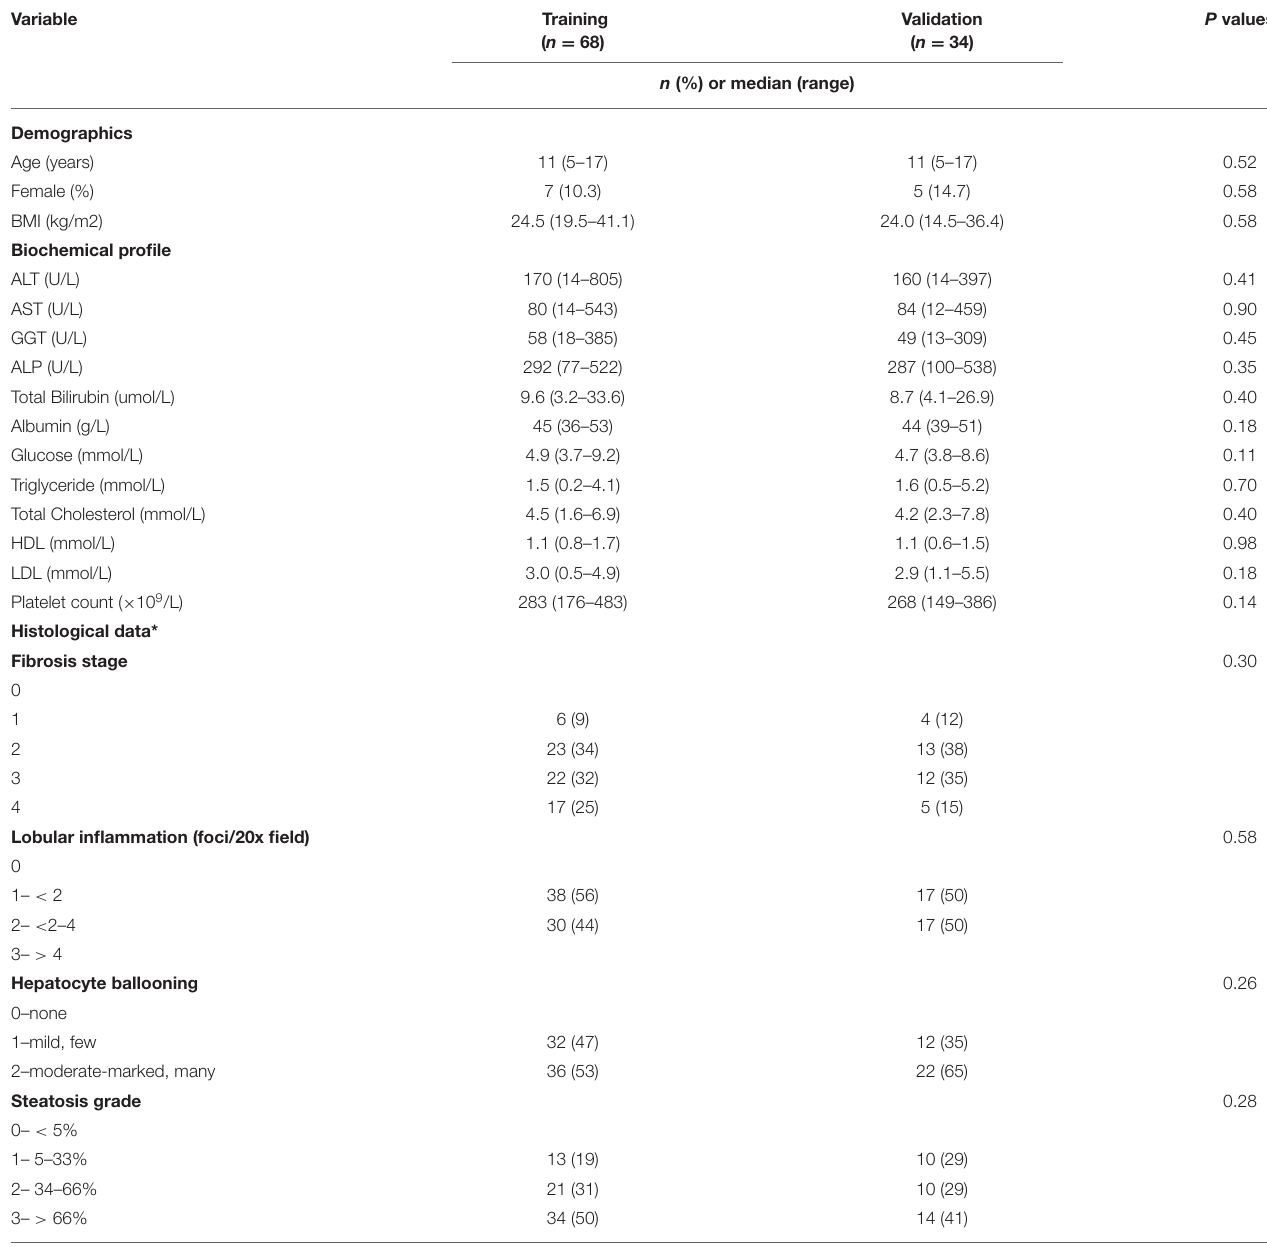
TABLE 1 | Laboratory and histological data of all